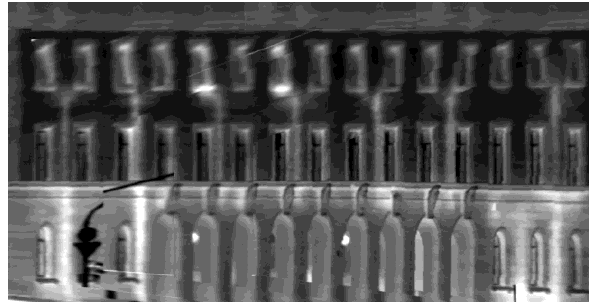
Figure 1. A thermal façade